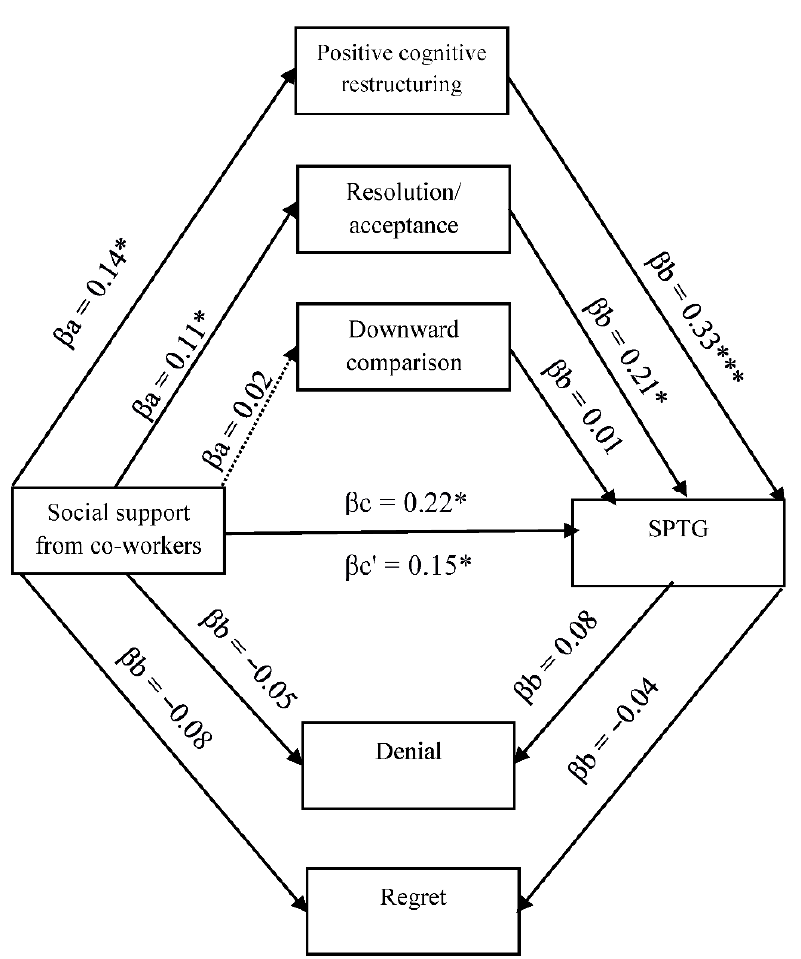
Figure 2. Model of relations between social support from co-workers, cognitive processing of trauma and secondary posttraumatic growth. β a,b—indirect effect; β c—total effect; β c’—direct effect. * p < 0.05; *** p < 0.001.